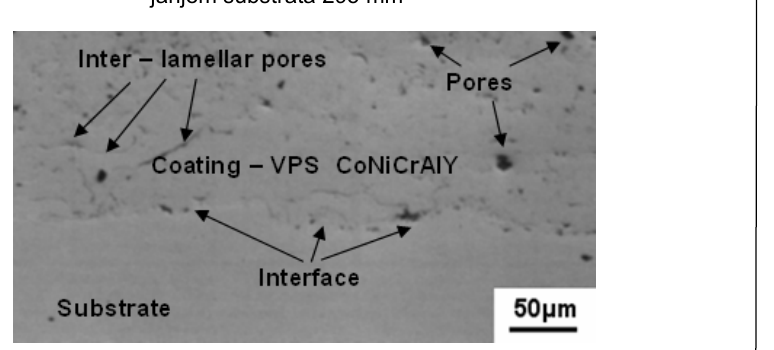
Figure 7 – Co32Ni21Cr8Al0.5Y coating microstructure deposited on the sample with a substrate distance of 320mm Slika 7 – Mikrostruktura Co32Ni21Cr8Al0.5Y prevlake deponovane na uzorku sa odstojanjem substrata